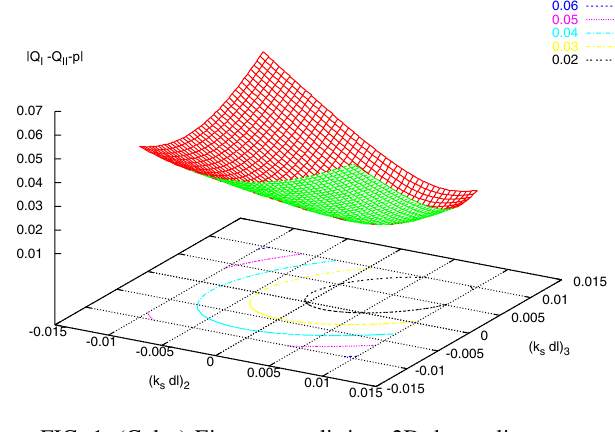
FIG. 2. (Color) Projection amplitude ratios R pling scan.